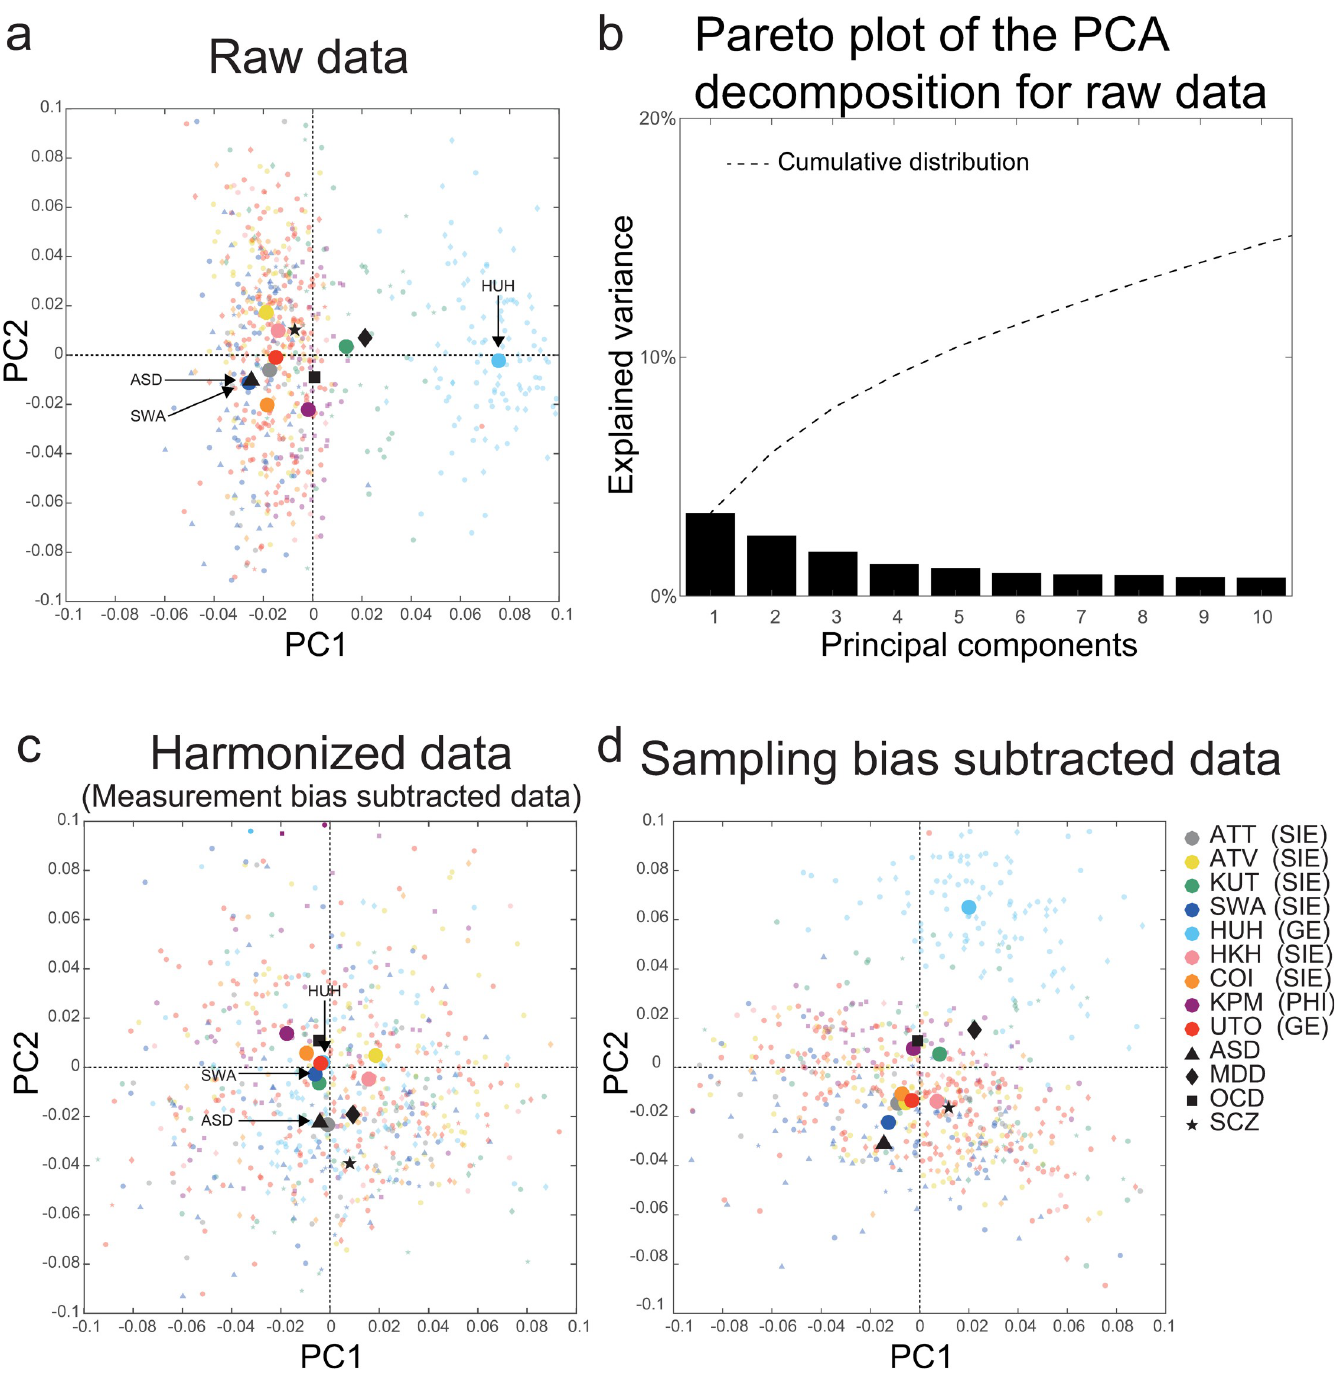
Fig 6. PCA dimension reduction in the SRPBS multidisorder dataset. Comparison among (a) Raw data, (c) Harmonized data (measurement bias subtracted data), and (d) Sampling bias subtracted data. All participants in the SRPBS multidisorder dataset projected into the first two PCs, as indicated by small, light-colored markers. Dark-colored markers indicate the averages of the projected data across healthy controls at each site and the average within each psychiatric disorder in the subspace spanned by the two components. The color of the marker represents the site, whereas the shape represents the psychiatric disorder. (b) The pareto plot of the PCA decomposition for raw data. The pareto plot shows how much variance is explained by each principal component. The numerical data used in this figure are included in S1 Data. ASD, autism spectrum disorder; ATT, Siemens TimTrio scanner at Advanced Telecommunications Research Institute International; ATV, Siemens Verio scanner at Advanced Telecommunications Research Institute International; COI, Center of Innovation in Hiroshima University; GE, GE functional magnetic resonance imaging; HKH, Hiroshima Kajikawa Hospital; HUH, Hiroshima University Hospital; KPM, Kyoto Prefectural University of Medicine; KUT, Siemens TimTrio scanner at Kyoto University; MDD, major depressive disorder; OCD, obsessive compulsive disorder; PC, principal component; PCA, PC analysis; PHI, Philips functional